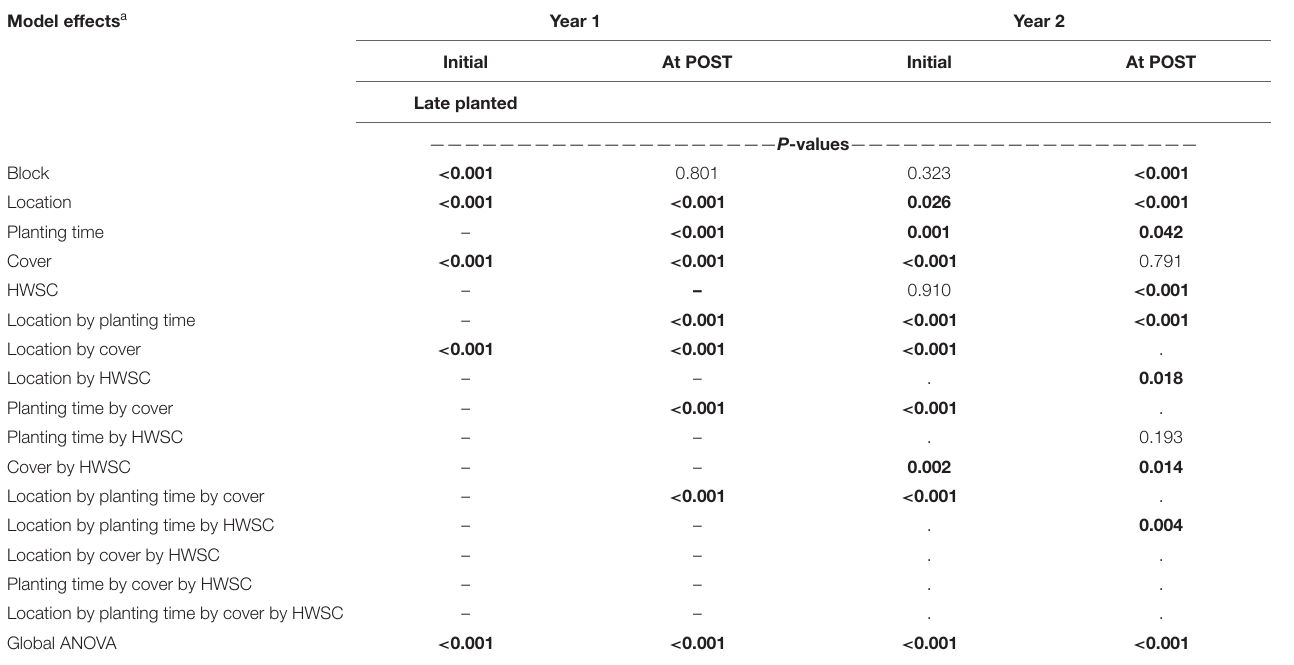
TABLE 3 | Effects table for initial common ragweed height and at POST herbicide application across all locations for year 1 of the field experiment at Blacksburg and Lawrenceville, VA, USA in 2017 and Blackstone, VA, USA in 2018. Model effects